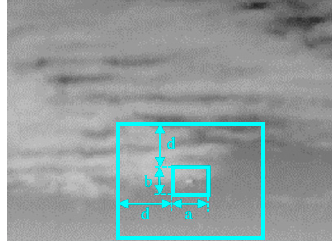
Figure 6. Infrared small target and its local area.